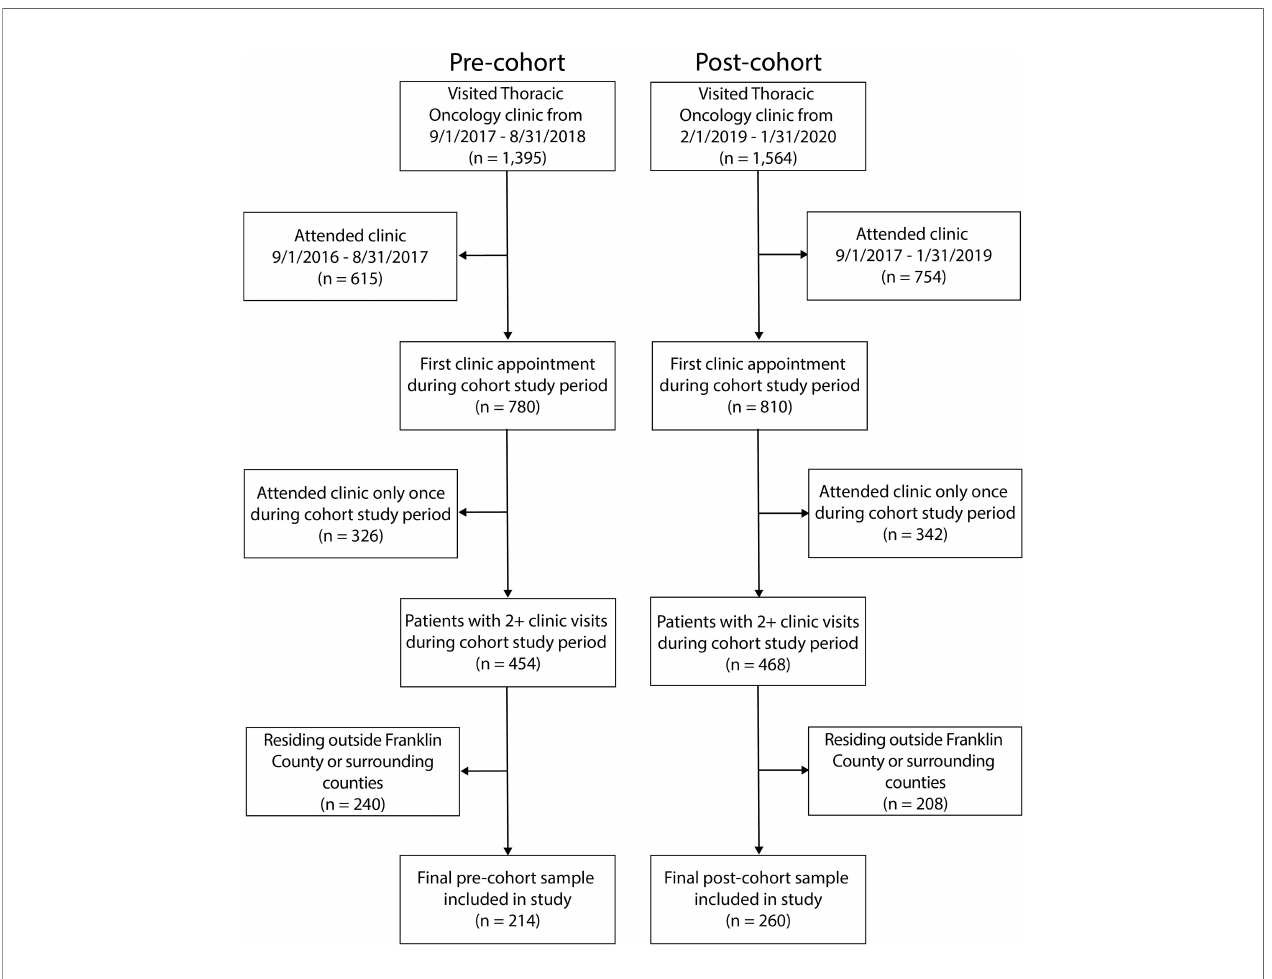
FIGURE 1 | Cohort